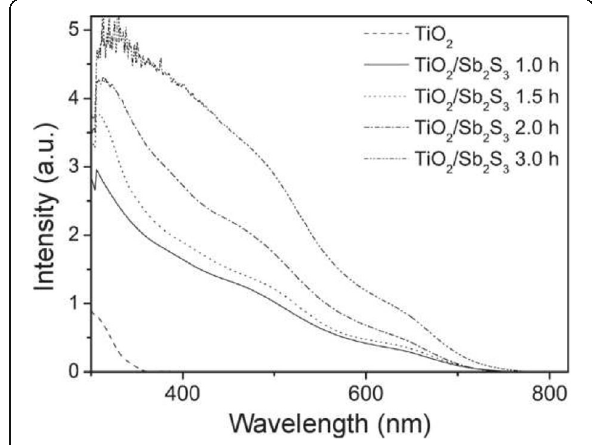
Fig. 4 The UV-vis absorption of TiO 2 and TiO 2 /Sb 2 S 3 films with t of 1 – 3 h,